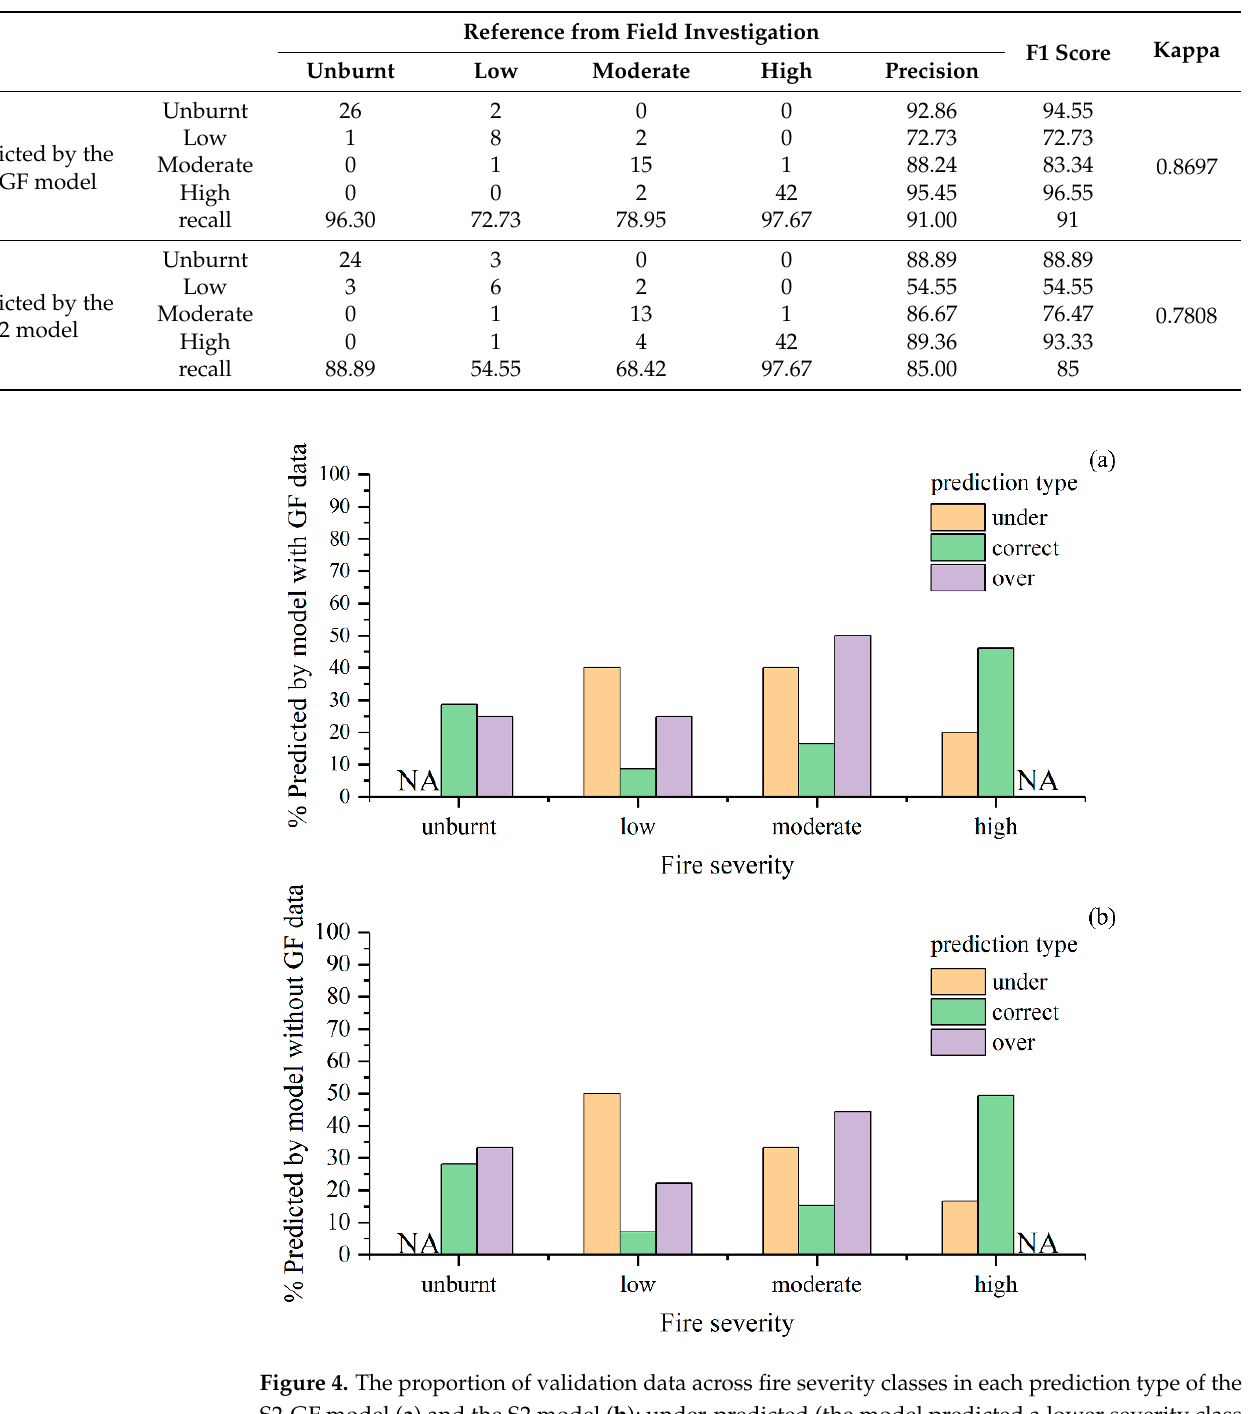
Figure 5. Ranked feature importance of each variable in the S2-GF model ( a ) and the S2 model ( b ), with 1 representing the most important feature. The figure only shows the top ten variables. Only